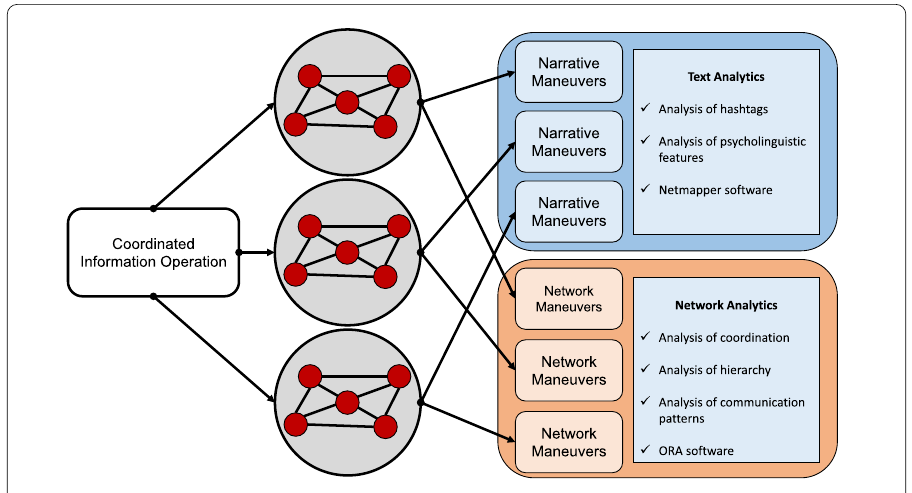
Figure 3 Conceptual framework of relationship between overarching information operations, specific narrative and network maneuvers enacted by account clusters, and the methods to characterize